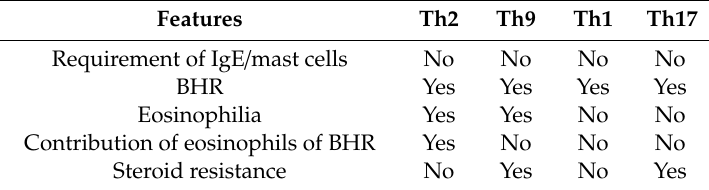
Table 2. Di ff erent features of Th cell subset-induced airway